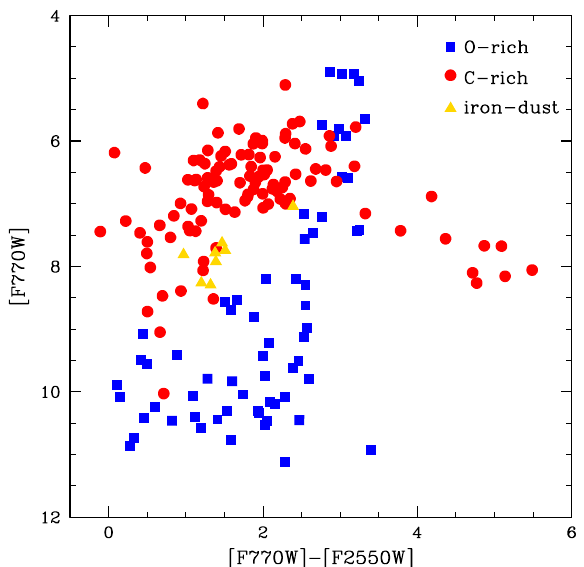
Figure 5. Distribution of AGB stars classified as C-stars (red circles) and oxygen-rich stars (blue squares) on the colour-magnitude ([F770W] − [F2500W], [F770W]) diagram. Yellow triangles indicate the oxygen-rich stars identified by [23] as the progeny of ∼ 5 M (cid:12) , metal-poor